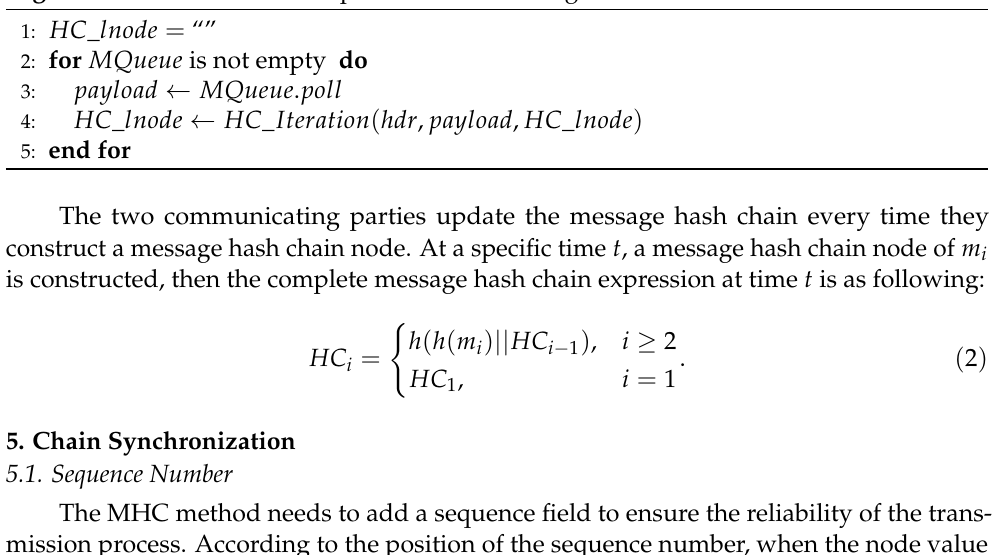
Algorithm 2 The construction process of the message hash